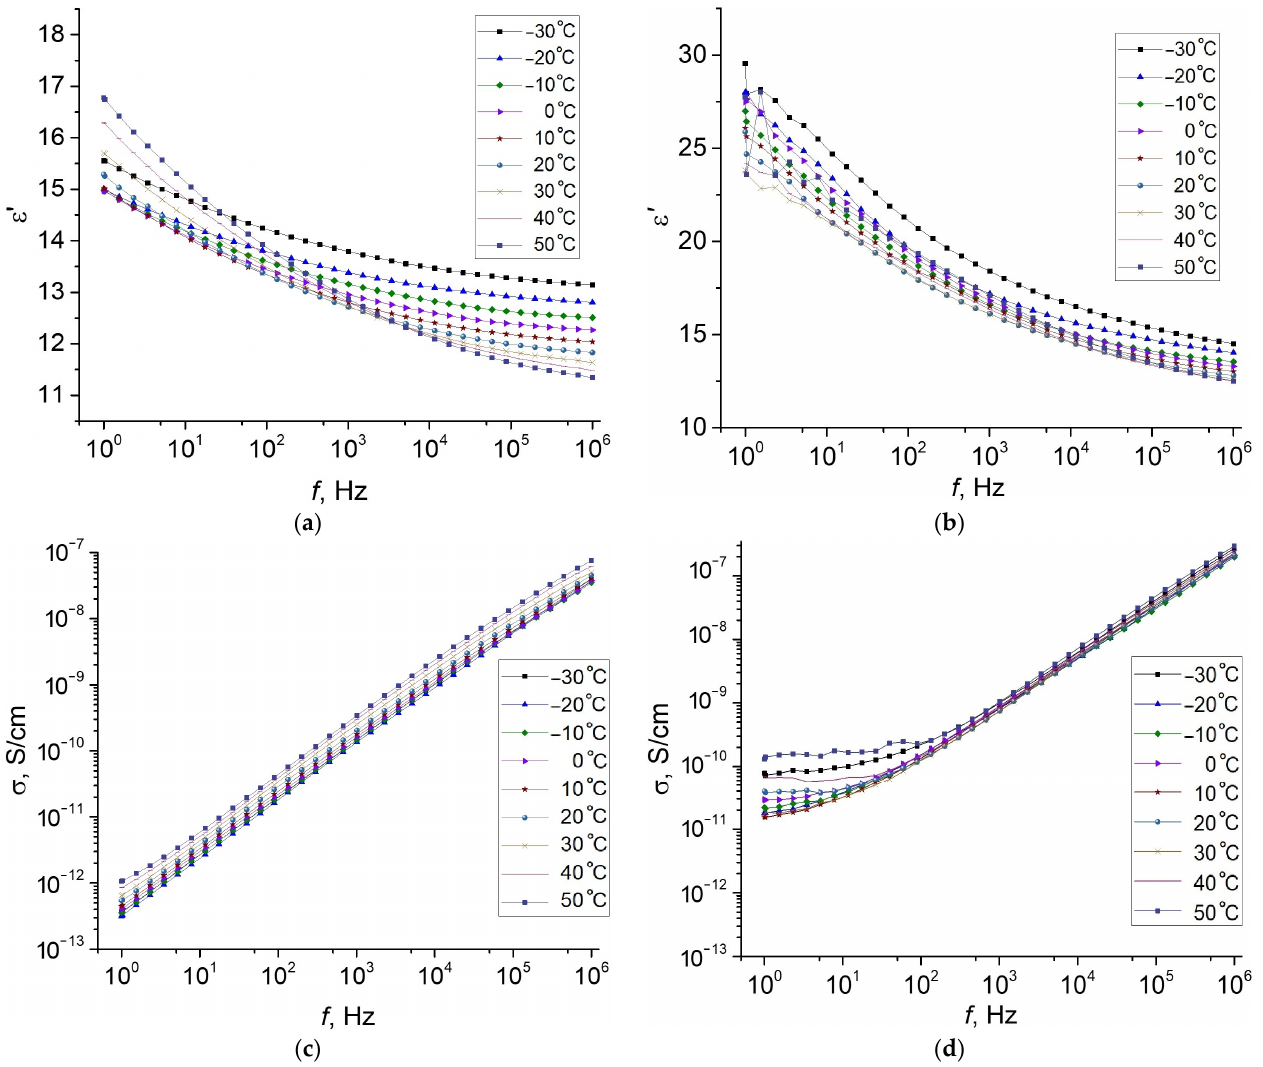
Figure 6. Frequency dependence of the dielectric permittivity ( a , c ) and conductivity ( b , d ) of MAE–0 ( a , b ) and MAE–0–m ( c,d ) at various temperatures.